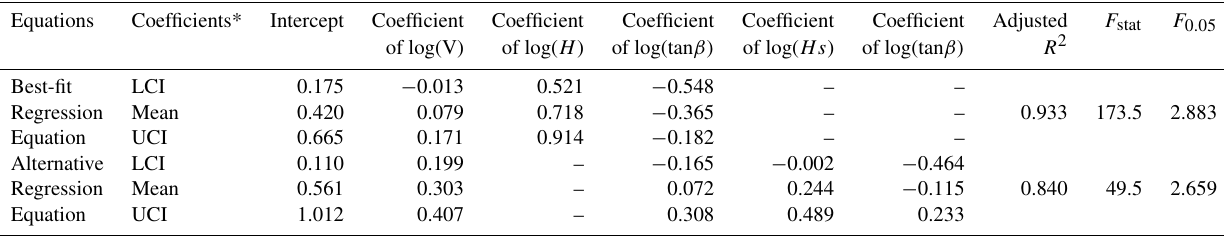
Table 4. The regression coefficients and results of significance tests of two multivariate regression models.